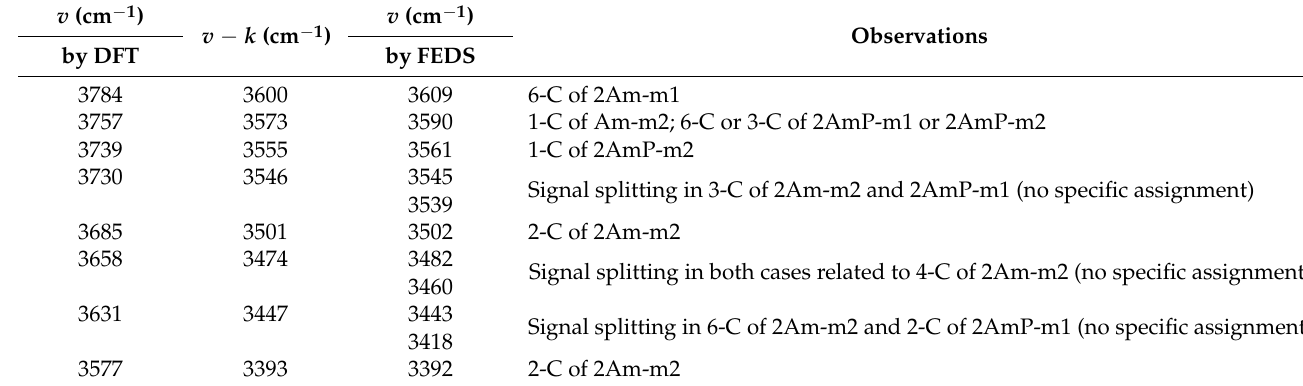
Table 2. Assignation of signals by FEDS and DFT ( k = ~184 cm − 1